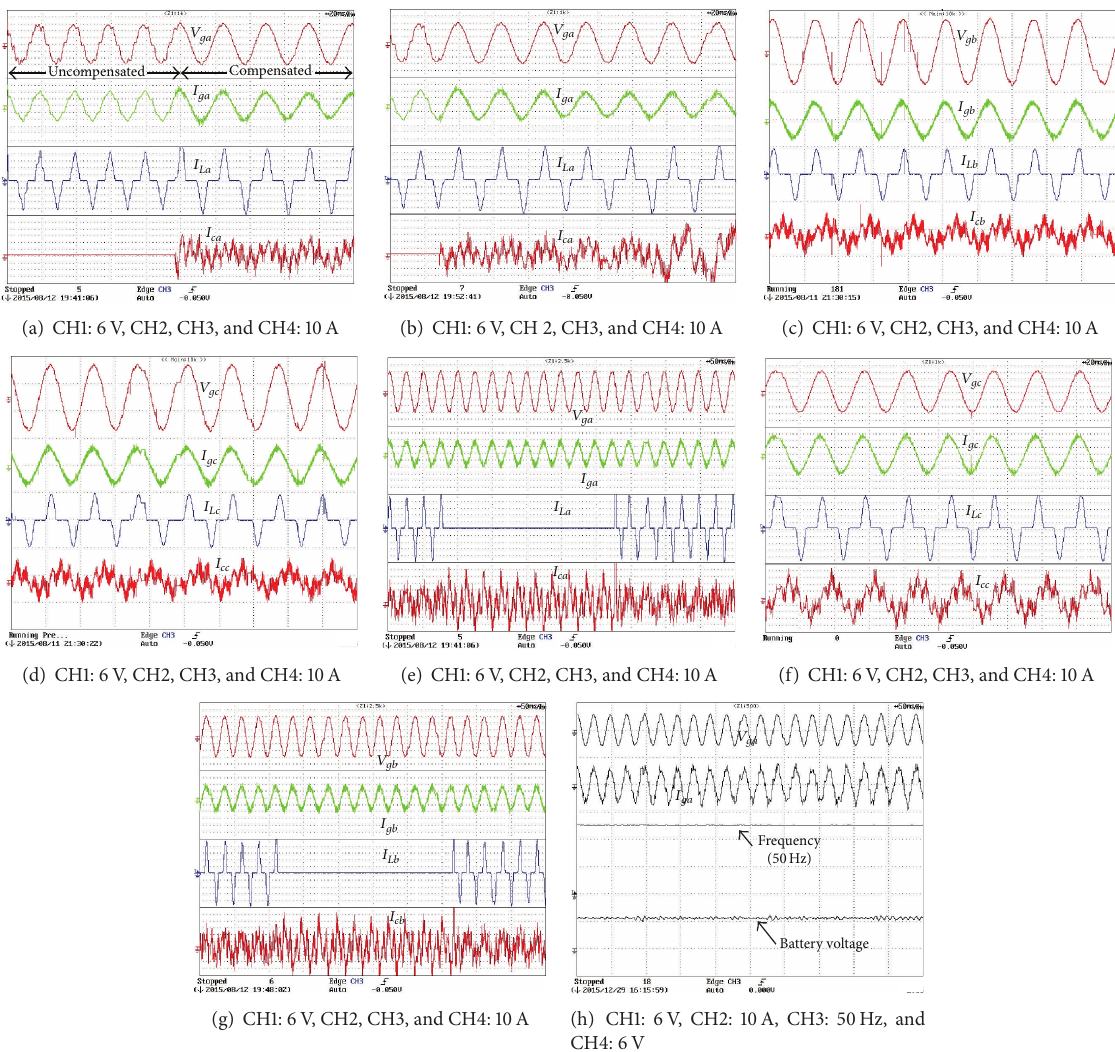
Figure 8: Experimental result for the proposed system on DSO (a) with/without controller: (b)–(d) load is balanced and (e)–(g) load is unbalanced. (h) Battery voltage, frequency with generator voltage, and current.